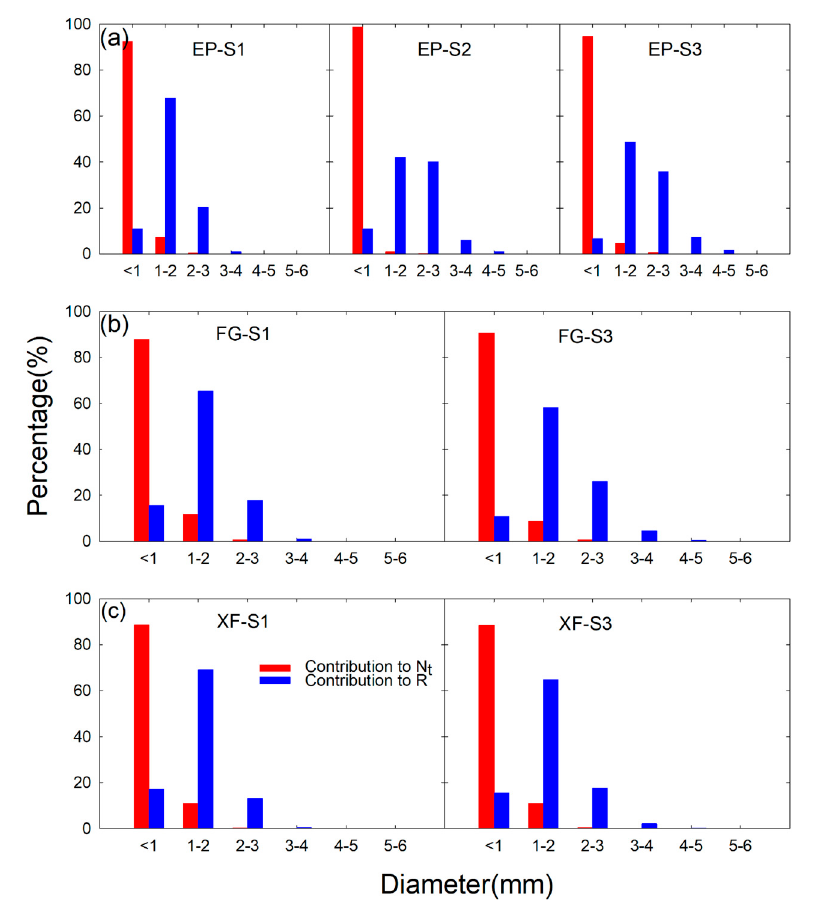
Figure 7. Relative contribution of each size class to the total raindrop concentration N t (red) and rain rate R (blue) for the entire dataset at the ( a ) EP, ( b ) FG, and ( c ) XF sites.